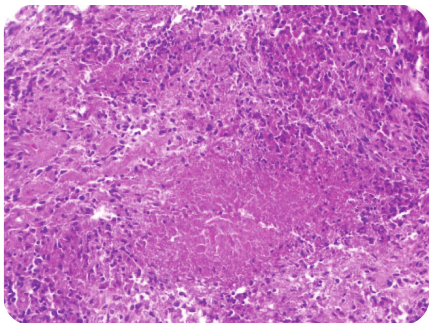
Figure 4: Histological examination revealing caseating granuloma- tous